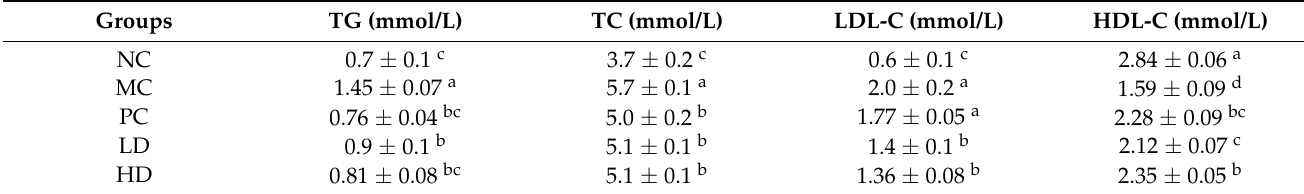
Table 2. Effect of EPS103 on serum lipid concentrations of T2DM